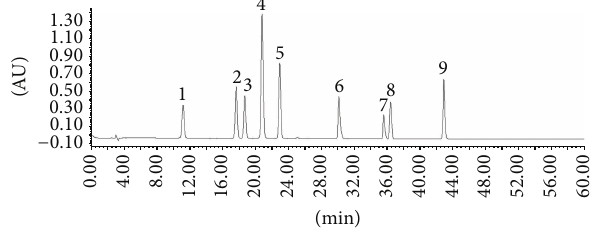
Figure 1: HPLC chromatograms of standard solution of nine compounds: (1) neochlorogenic acid; (2) chlorogenic acid; (3) cryptochlorogenin acid; (4) caffeic acid; (5) geniposide; (6) secoxy- loganin; (7) isochlorogenic acid B; (8) isochlorogenic acid A; (9) isochlorogenic acid